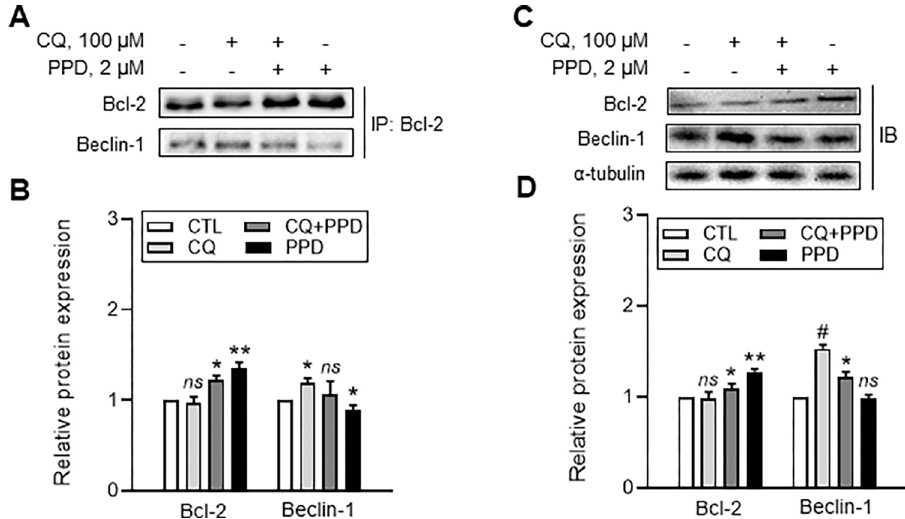
Fig 5. Protopanaxadiol (PPD)-induced alteration on chloroquine-mediated interaction of Beclin-1 BH3 domain with Bcl-2 and cell proliferation associated signaling in adult retinal pigment epithelial (ARPE)-19 cells. ARPE-19 cell lysates (A, B) immunoprecipitated (IP) or (C, D) immunoblotted (IB) with antibodies. Cells were treated with vehicle, 100 μ M CQ, 2 μ M PPD+100 μ M CQ, and 2 μ M PPD for 6 h, followed by IP and IB. Data are means ± standard deviation (SD), n = 3; ns , � P < 0.05, �� P < 0.01, and # P < 0.001 vs each